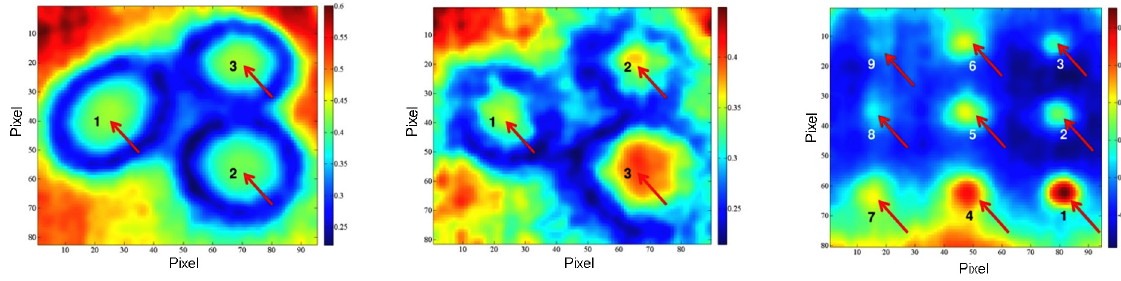
Fig. 3. Correlogram, BM 1-3, bottom surface, distance 2 m